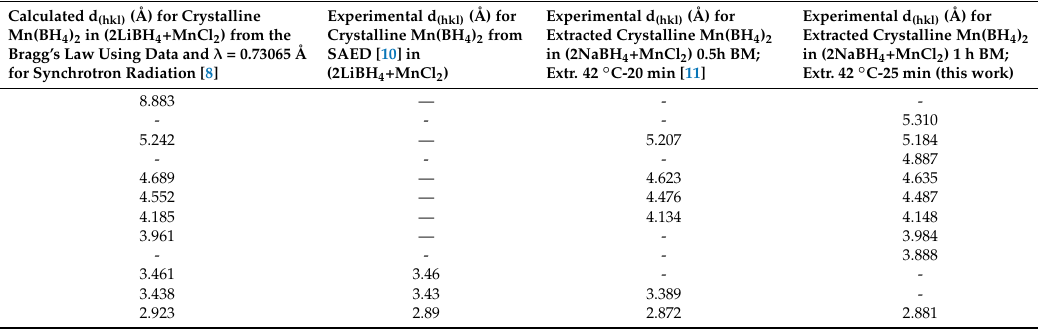
Table 2. Experimental lattice spacings, d(hkl), for filtered/extracted, crystalline c-Mn(BH 4 ) 2 obtained in this work from the 0.5 and 1h ball milled (2NaBH 4 + MnCl 2 ) samples, compared to d (hkl) values calculated from synchrotron radiation [8] and to the experimental ones obtained from SAEDP (selected area electron diffraction pattern) by Shirani Bidabadi et al. [10]. Calculated d (hkl) (Å) for Crystalline Mn(BH 4 ) 2 in (2LiBH 4 +MnCl 2 ) from the Bragg’s Law Using Data and λ = 0.73065 Å for Synchrotron Radiation